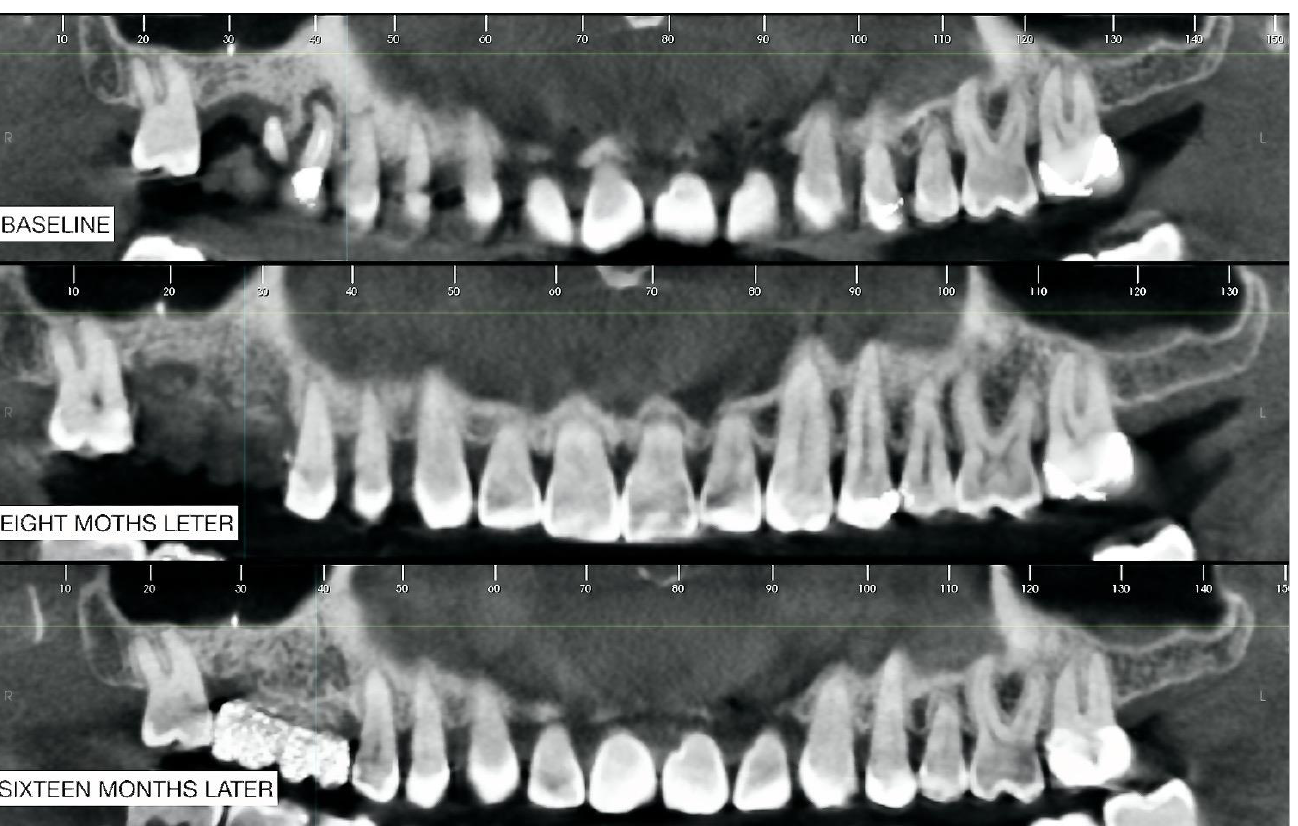
Figure 13. Comparison of panoramic cuts.